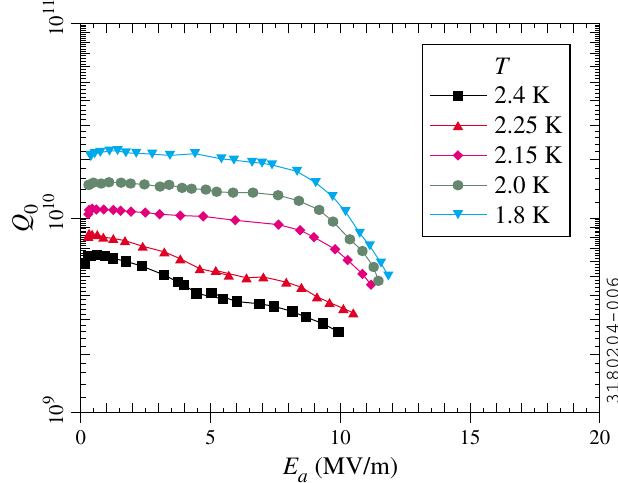
FIG. 9. (Color) Measured dependence of the quality factor on the accelerating gradient at different bath temperatures for the first 6-cell cavity prototype (January